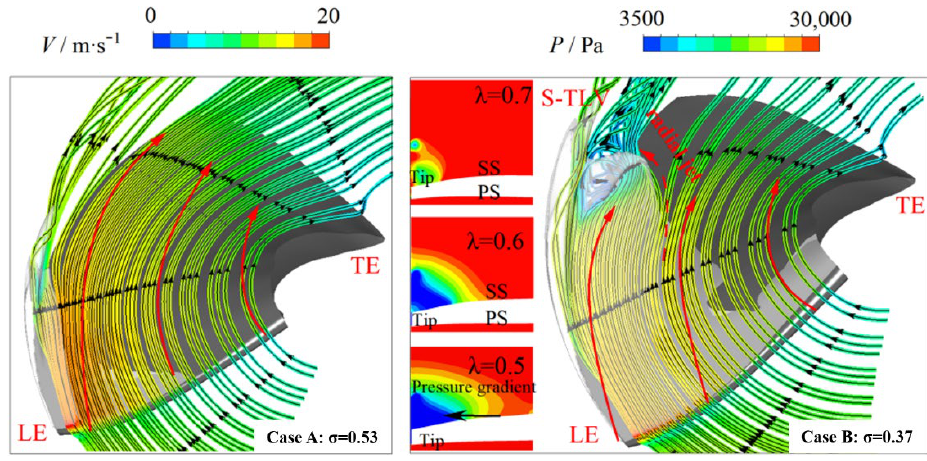
Figure 14. Velocity streamlines and cavitation distributions on the suction surface of the blade.